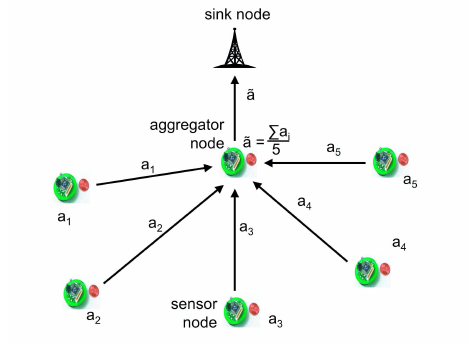
Fig. 1. Illustration of data